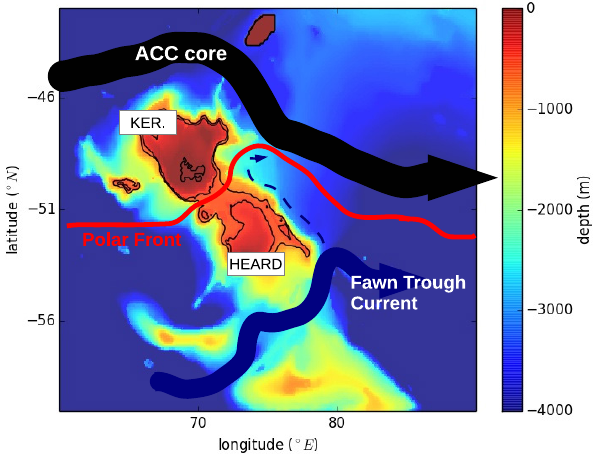
Figure 1. Bathymetry and a sketch of the main current branches. The thick 500m isobath identifies the Kerguelen and Heard plateaux. The 750m isobath marks the shelf